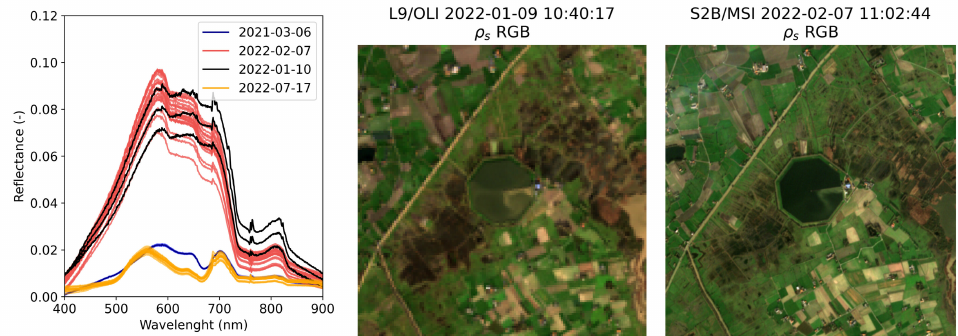
Figure 9. Time series of SPM (g/m 3 ) retrieved with HYPSTAR using the algorithm of Nechad et al. (2010) with the 700 nm band, and gustwind (m/s) (retrieved from the VLINDER station at Blankaart) from January 2021 to August 2022.